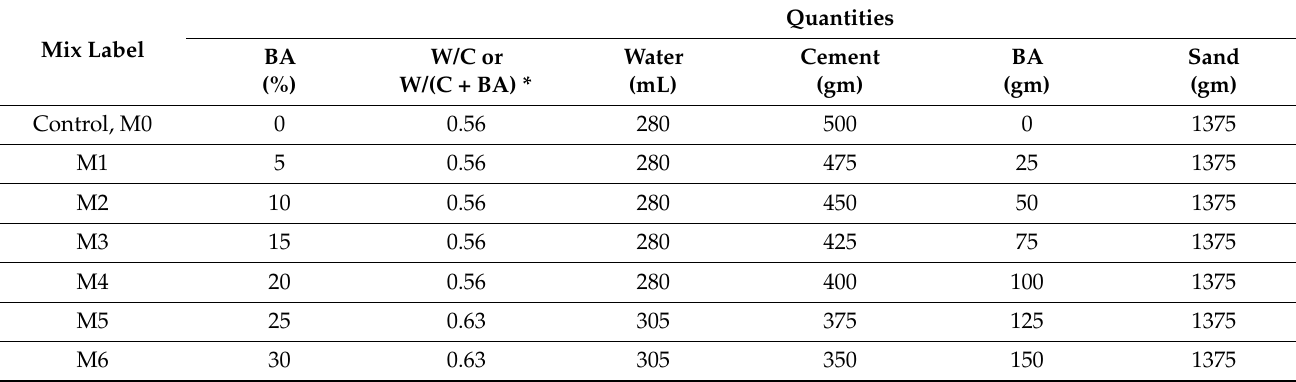
Table 4. Mix design of mortar with BA (for six cube